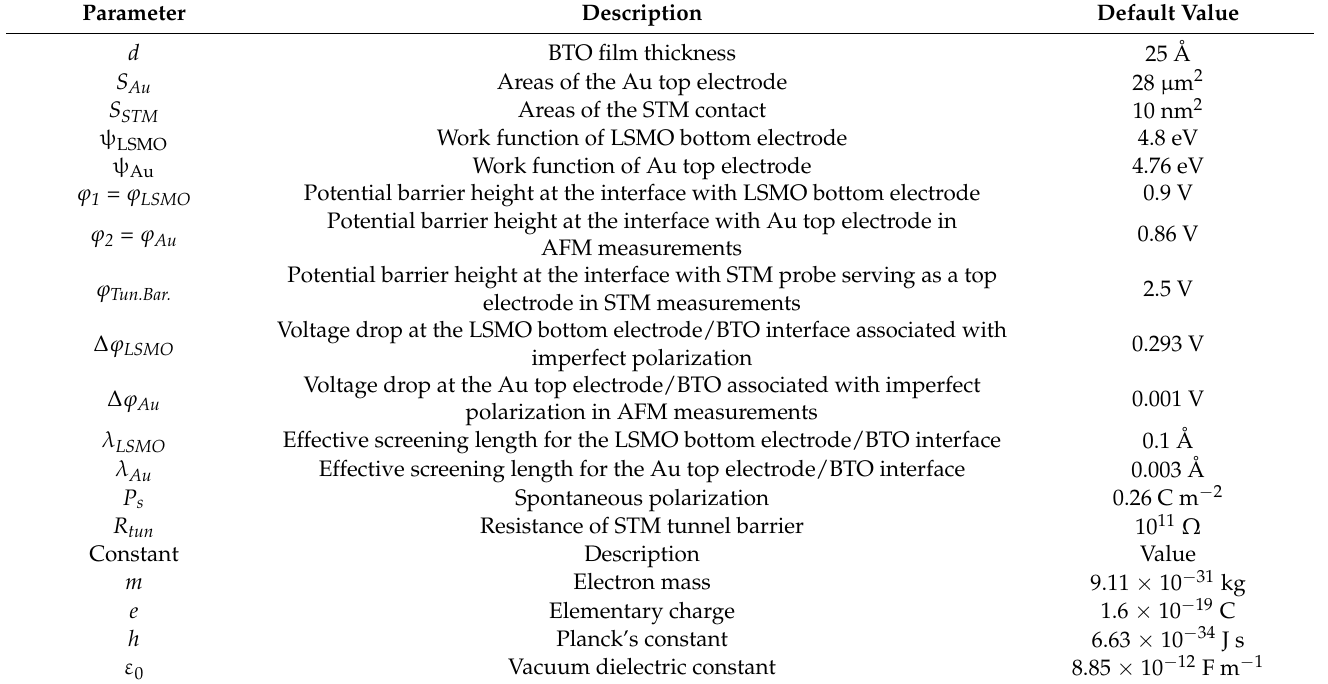
Table 1. Parameters for modelling I-V characteristics in measurements with AFM and STM